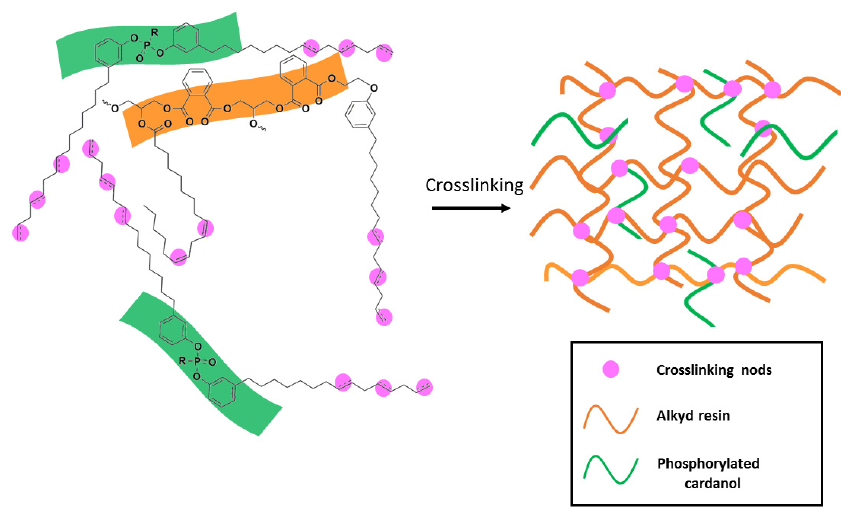
Figure 1. General scheme of crosslinking cordanol-modified alkyd resin containing phosphorylated cardanol (R = OPh (PO 4 CR) or Ph (PO 3 CR)).